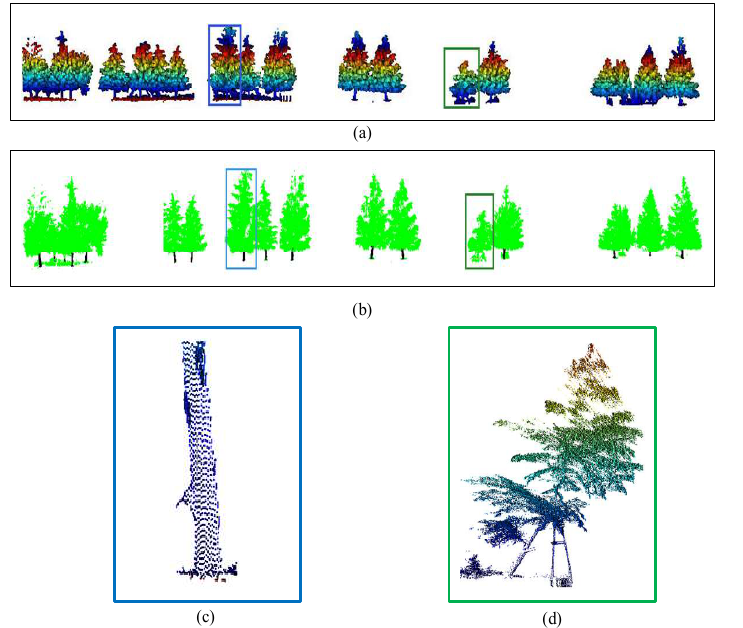
Figure 15. Processing result for dataset 4: ( a ) individual tree segmentation; ( b ) trunk extraction; ( c ) trunk with much noise; ( d ) trunk extraction failed.